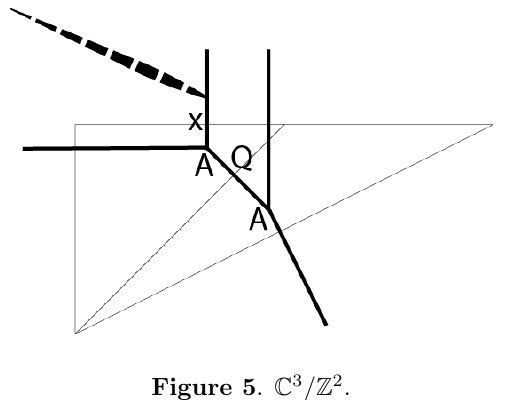
Figure 5 . C 3 = Z 2